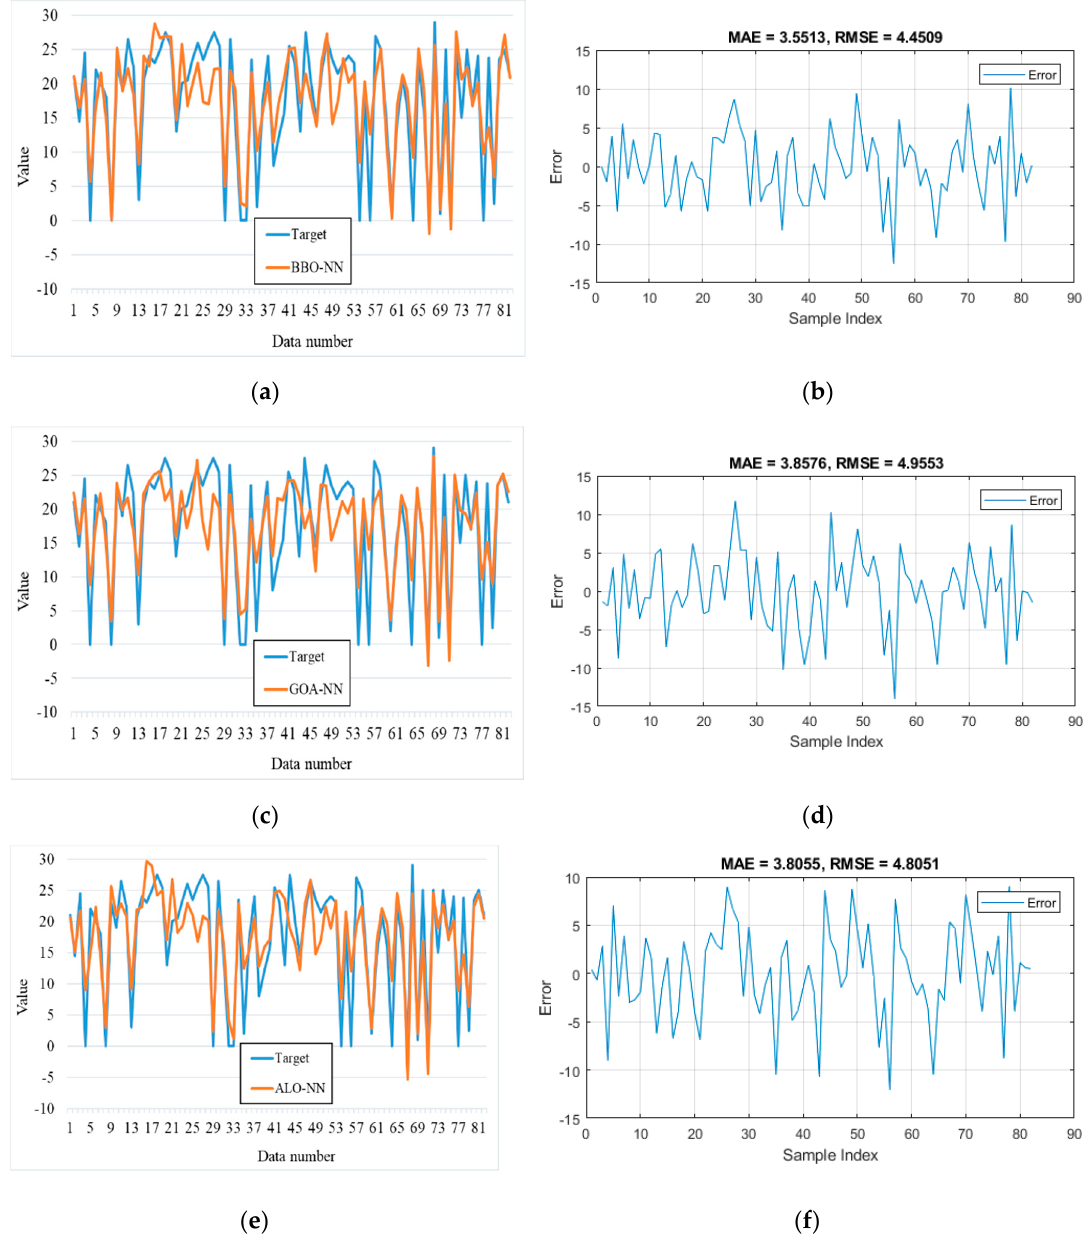
Figure 7. The training results obtained for ( a , b ) BBO-NN, ( c , d ) GOA-NN, and ( e , f ) ALO-NN predictions.